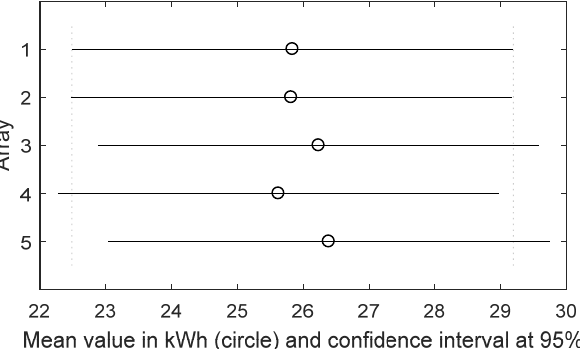
Figure 7. Mean value of the energy produced by each array for the three-months analysis (January– March). Table 4. One-to-one comparison of the means for the three-months analysis (January–March). Comparison between Samples